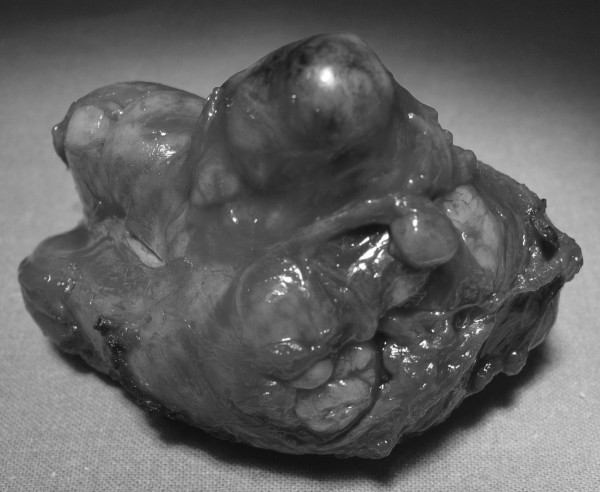
Surgical specimen.